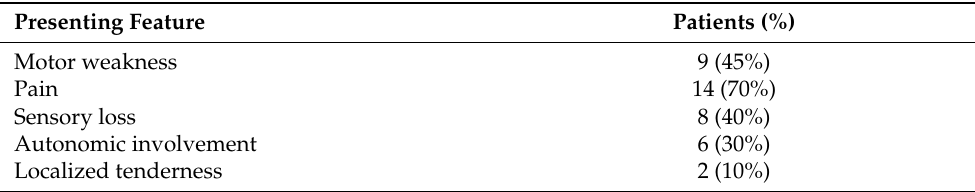
Table 3. Clinical